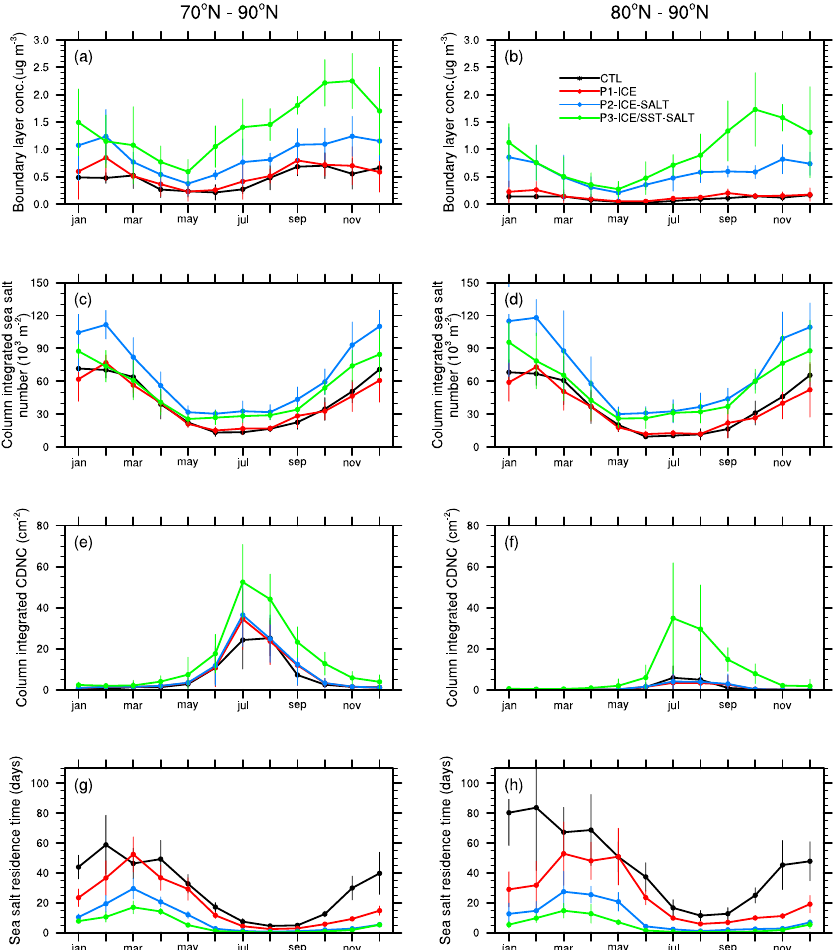
Fig. 9. (a) , (b) Modeled Arctic sea salt boundary layer concentrations (µgm − 3 ), (c) , (d) sea salt aerosol column burdens (10 3 cm − 2 ), (e) , (f) vertically integrated cloud droplet number concentration (cm − 2 ) and (g) , (h) sea salt aerosol residence times in days. Averages are taken over ocean grid points only for the final five years of the model integrations. Vertical lines indicate the two standard deviations corresponding to the monthly